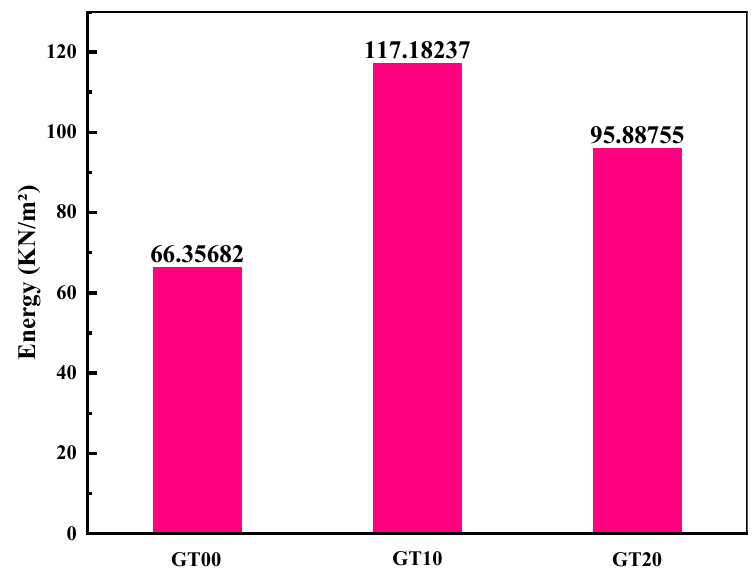
Figure 20. The energy required for crack propagation in the initial stress stage. Flexural Section The respective section was divided into 16 regions, and an in-depth analysis was conducted to generate Figure 23. The red circle represents less than 10 steel fibers and the green circle represents more than 10 steel fibers. According to Figure 23a,b, there were eight areas with fiber number less than 10, three areas with fiber number greater than 20 and 21 areas with fiber numbers between 10 and 20 in the 32 areas in the GT00 cross-section. There were five areas where the number of fibers was less than 10, five areas where the number of fibers exceeded 20 and 20 areas where the number of fibers ranged from 10 to 20 in the 32 areas in the GT10 cross-section. There were six areas where the number of fibers was less than 10, five areas where the number of fibers exceeded 20 and 21 areas where the number of fibers ranged from 10 to 20 in the 32 areas of the GT20 cross-section.